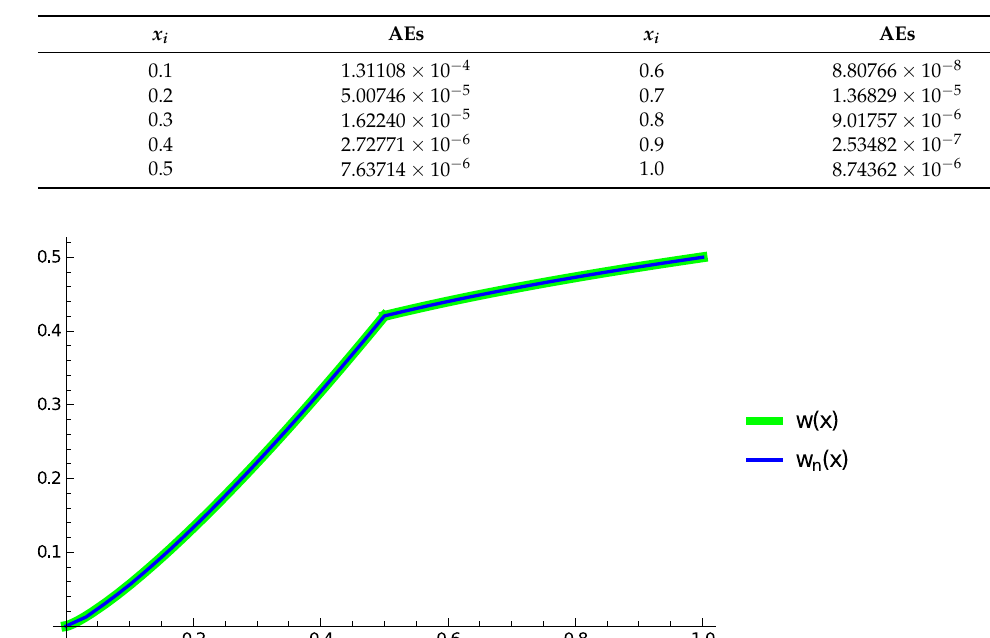
Table 5. The AEs for Example 4.